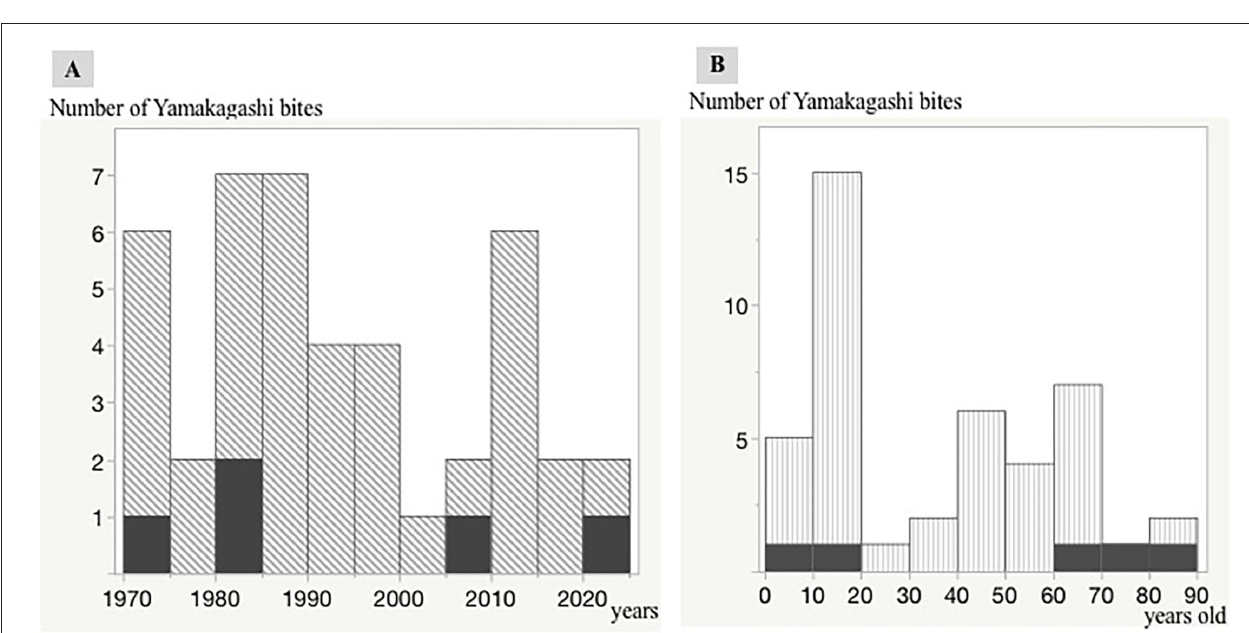
FIGURE 1 | Geographical features of R. tigrinus bites. (A) All cases (from 1971 to 2020). (B) Cases after 2000. (C) Fatal cases.